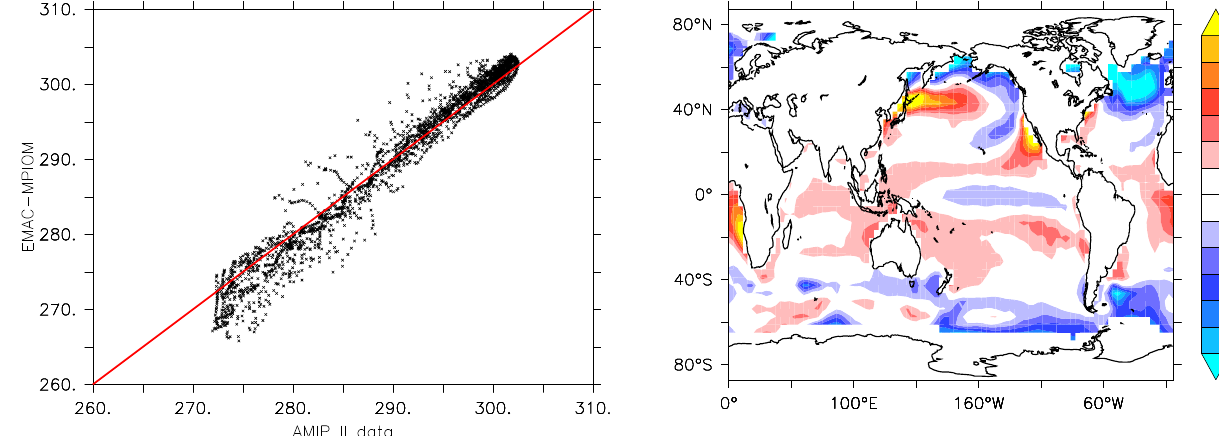
Fig. 6. Surface temperature differences between the AMIP II (Tay- lor et al., 2000) dataset and the simulation TRANS (inK). Both datasets have been averaged over the years 1960–1990.